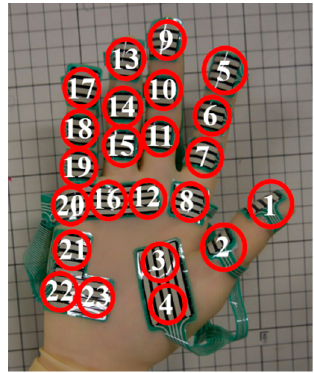
Figure 5. Regions on the pressure sensor sheet used in the experiment [6].